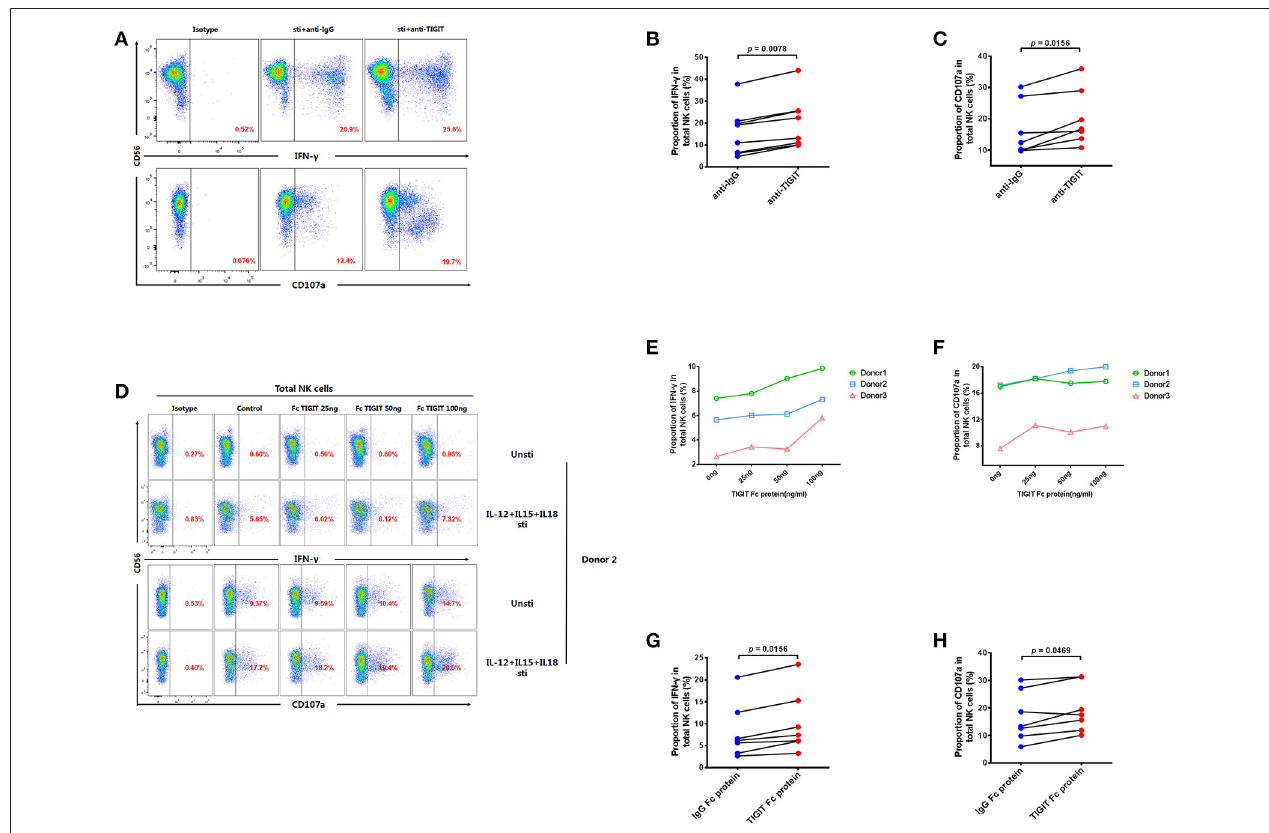
FIGURE 5 | Blocking TIGIT can restore the function of NK cells in HIV-infected individuals. (A) A representative flow cytometry plot showing the proportion of IFN- γ producing NK cells after treatment with 5 µ g/mL anti-human TIGIT antibodies or purified mouse IgG (as a negative control) from HIV-infected individuals. The expression of IFN- γ was gated according to an isotype control. (B) Paired comparisons of the proportions of IFN- γ producing NK cells after treatment with 5 µ g/mL anti-human TIGIT antibodies or purified mouse IgG (as a negative control) from HIV-infected individuals ( n = 8). (C) Paired comparisons of the proportion of CD107a expressed by NK cells after treatment with 5 µ g/mL anti-human TIGIT antibodies or purified mouse IgG (as a negative control) from HIV-infected individuals ( n = 7). (D) A representative flow cytometry plot demonstrating the effects of different doses of rTIGIT (0 (medium only), 20, 50, and 100ng/mL) on IFN- γ and CD107a production by NK cells. (E) Proportion of IFN- γ + NK cells from HIV-infected individuals after treatment with different concentrations of rTIGIT (0, 20, 50, and 100ng/mL; n = 3). (F) Proportion of CD107a + NK cells from HIV-infected individuals after treatment with different concentrations of rTIGIT (0, 20, 50, and 100ng/mL; n = 3). (G) Paired comparisons of the proportion of IFN- γ producing NK cells after treatment with 50ng/mL rTIGIT or rIgG from HIV-infected individuals ( n = 7). (H) Paired comparisons of the proportion of CD107a-expressing NK cells after treatment with 50ng/mL rTIGIT or rIgG from HIV-infected individuals ( n = 7). Wilcoxon matched-pairs signed-rank tests were used for comparisons between paired groups. p < 0.05 was considered